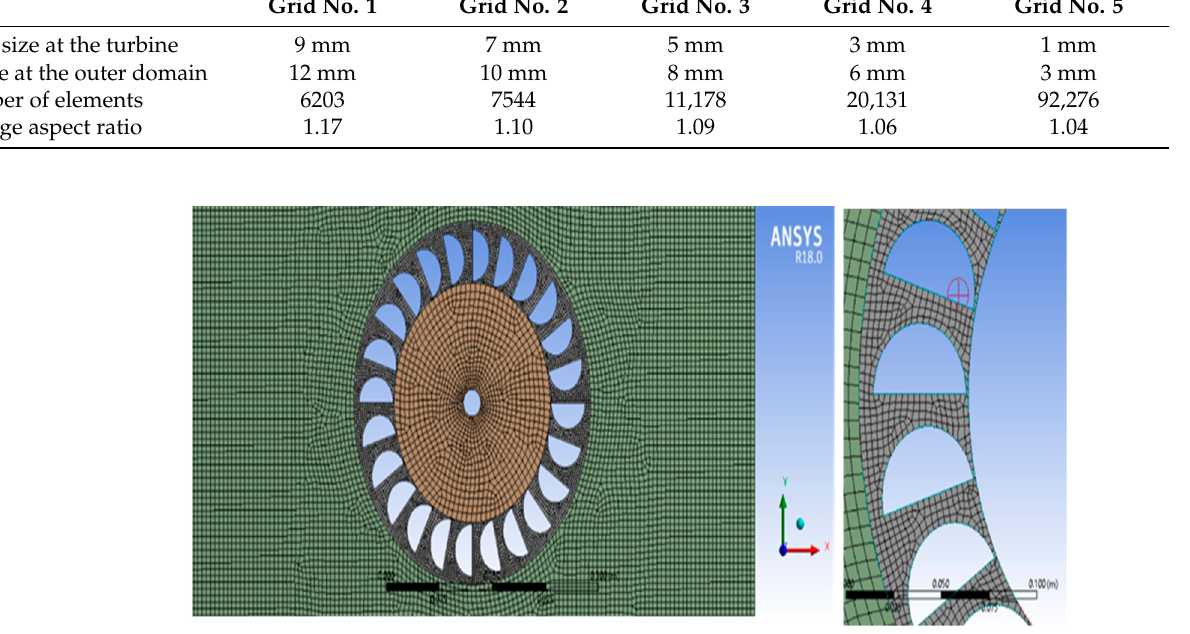
Figure 4. Mesh geometry.